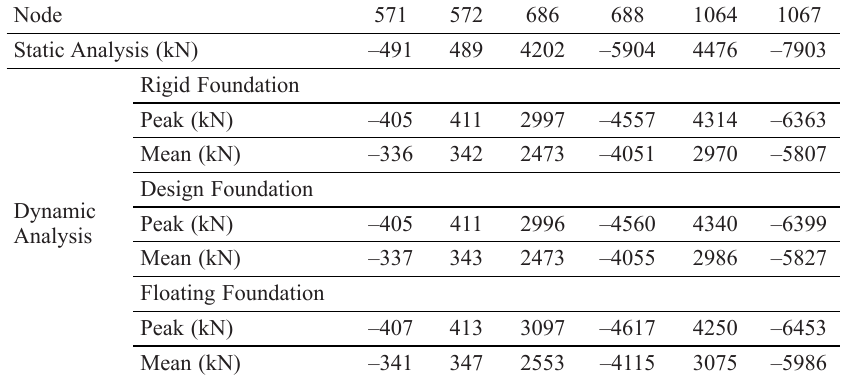
Table 7. Axial forces in some members of the tower GTS 01 due to EPS wind